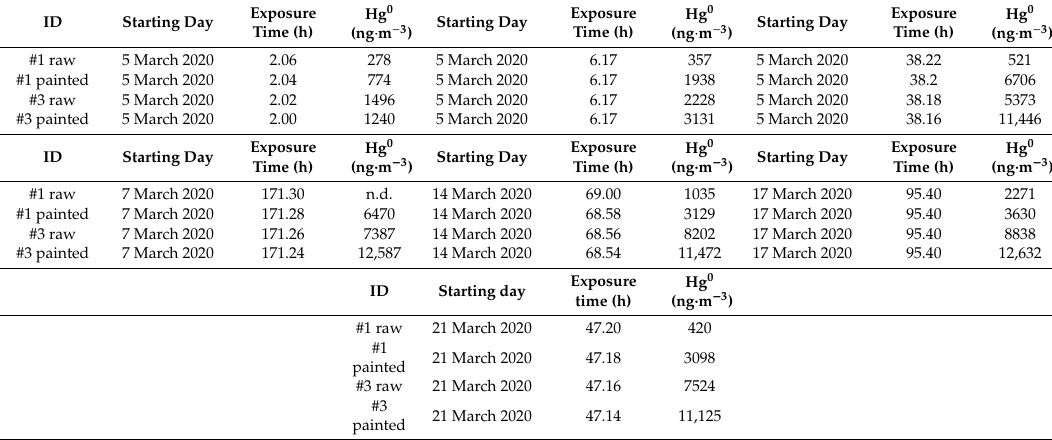
Table 3. Experimental tests on “raw” and “painted” fragments of samples 1 and 3 to evaluate the release of Hg 0 at di ff erent exposure